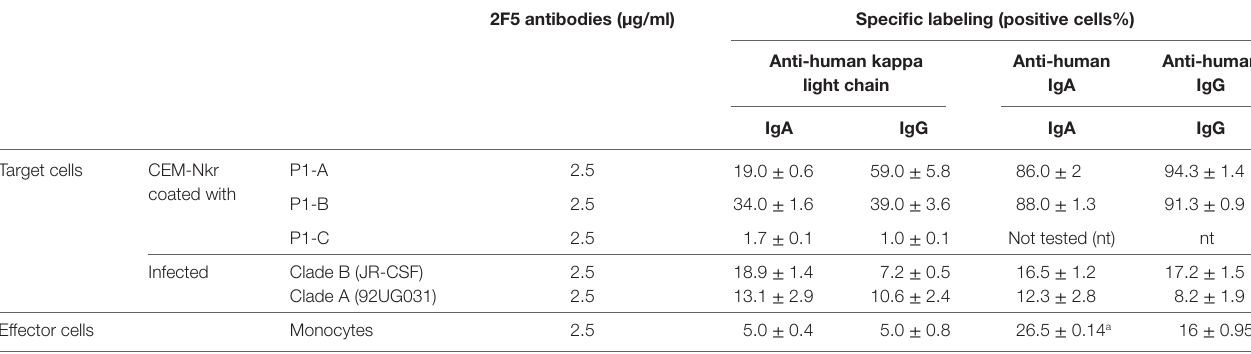
TaBle 1 | P1 Clade A and B-specific 2F5-IgA and IgG binding to effector and target cells.